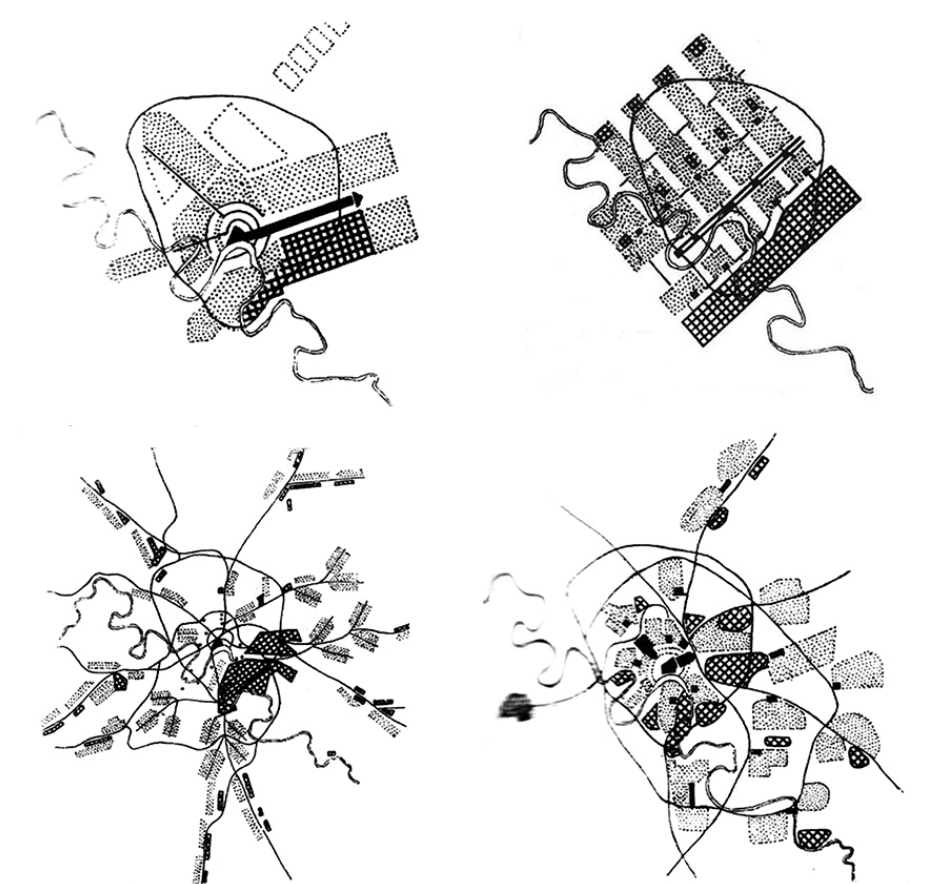
Figure 3. A selection of entries for the Moscow Green City competition. From left to right: brigade of Kratuk (urbanists), WOPRA brigade (urbanists), Hannes Meyer (disurbanists) and Ernst May (disurbanists). Source: Cohen, de Michelis and Tafuri (1930, pp.